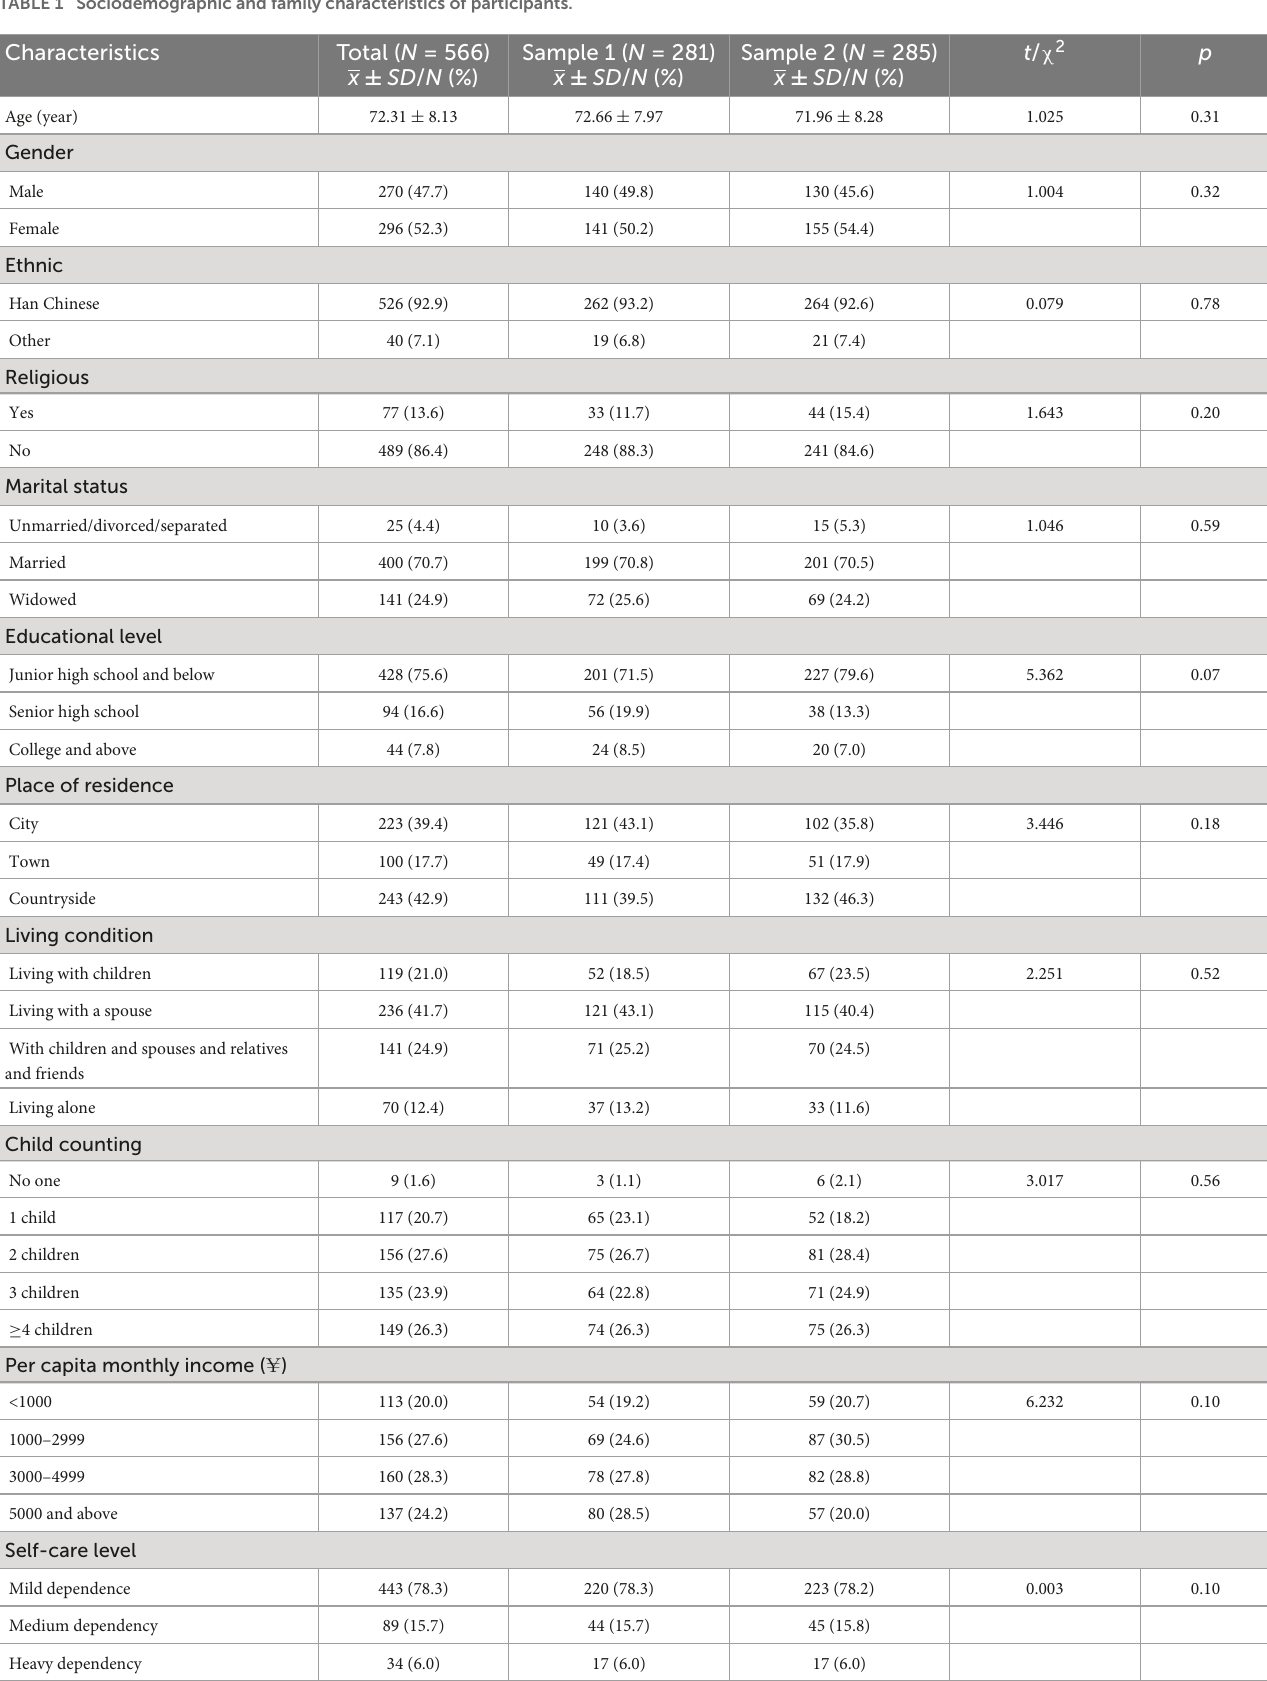
TABLE 1 Sociodemographic and family characteristics of participants.